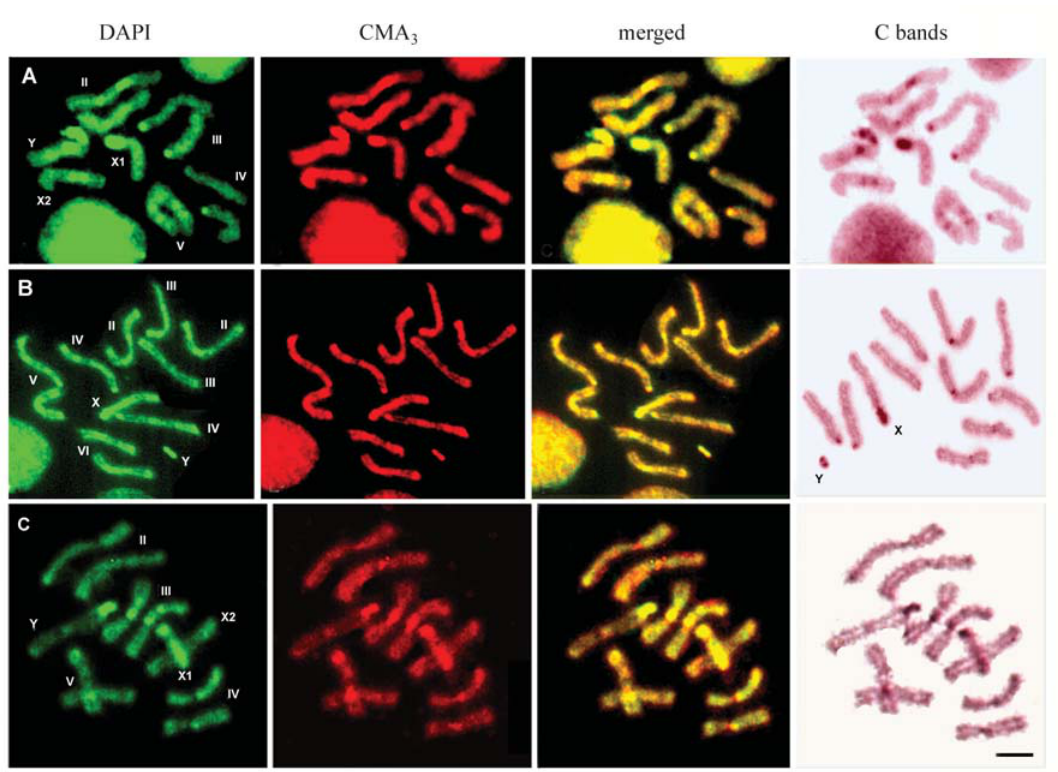
Figure 1 - Metaphases of males of Anastrepha bistrigata , 2n = 12 (A), A. striata , 2n = 11 (B) , and A. serpentina, 2n = 11 (C), sequentially stained with DAPI and chromomycin A3 followed by C-banding. The original images of the chromosomes stained by the fluorochromes were pseudocolored in green (DAPI)andred(CMA 3 ),andthethirdcolumnshowsthemergedpictures.TheheterochromaticblocksrevealedbyC-bandingshoweddifferentialaffinity for the fluorochromes, thus indicating that they are either AT- or GC-rich. Only in A. serpentina the pericentromeric heterochromatin of the autosomes is GC-rich. Bright yellow: colocalization of AT- and GC-rich DNA sequences; orange: colocalization of GC- and AT-rich sequences, but with preponder- ance of GC; green: AT-rich regions; red: GC-rich DNA blocks. Bar represents 10 μ